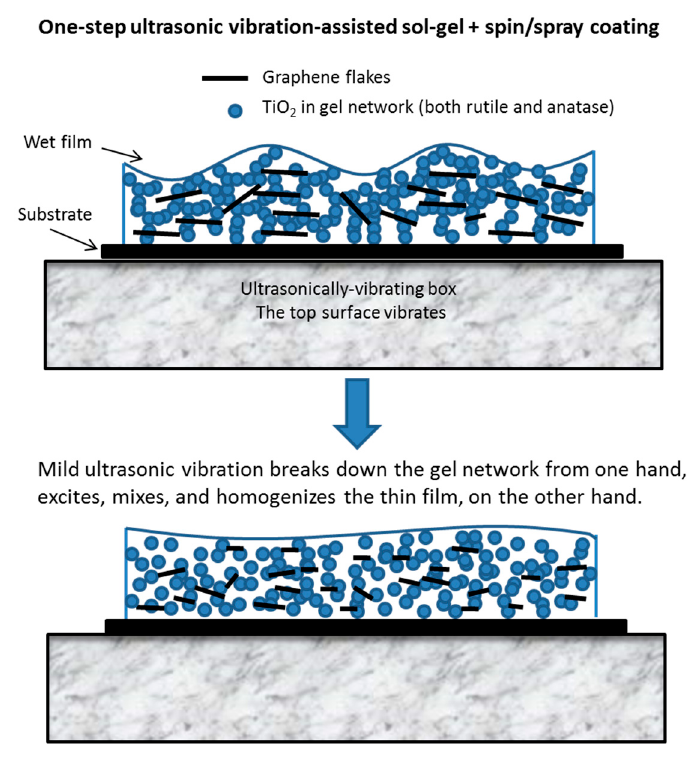
Figure 12. The process of graphene ‐ TiO 2 thin film formation by low ‐ temperature ultrasonic vibration ‐ assisted spin and spray coating in a sol ‐ gel route.